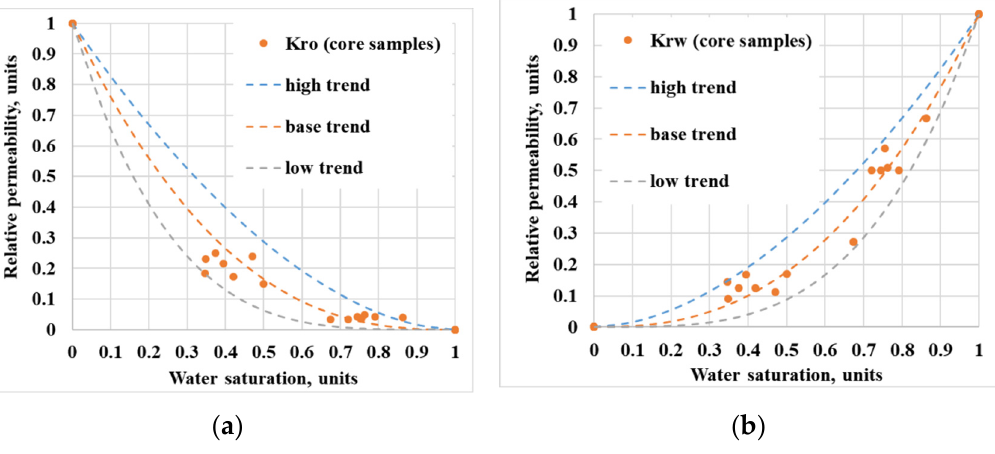
Figure 5. Relative permeability to: ( a ) oil ( b ) water.